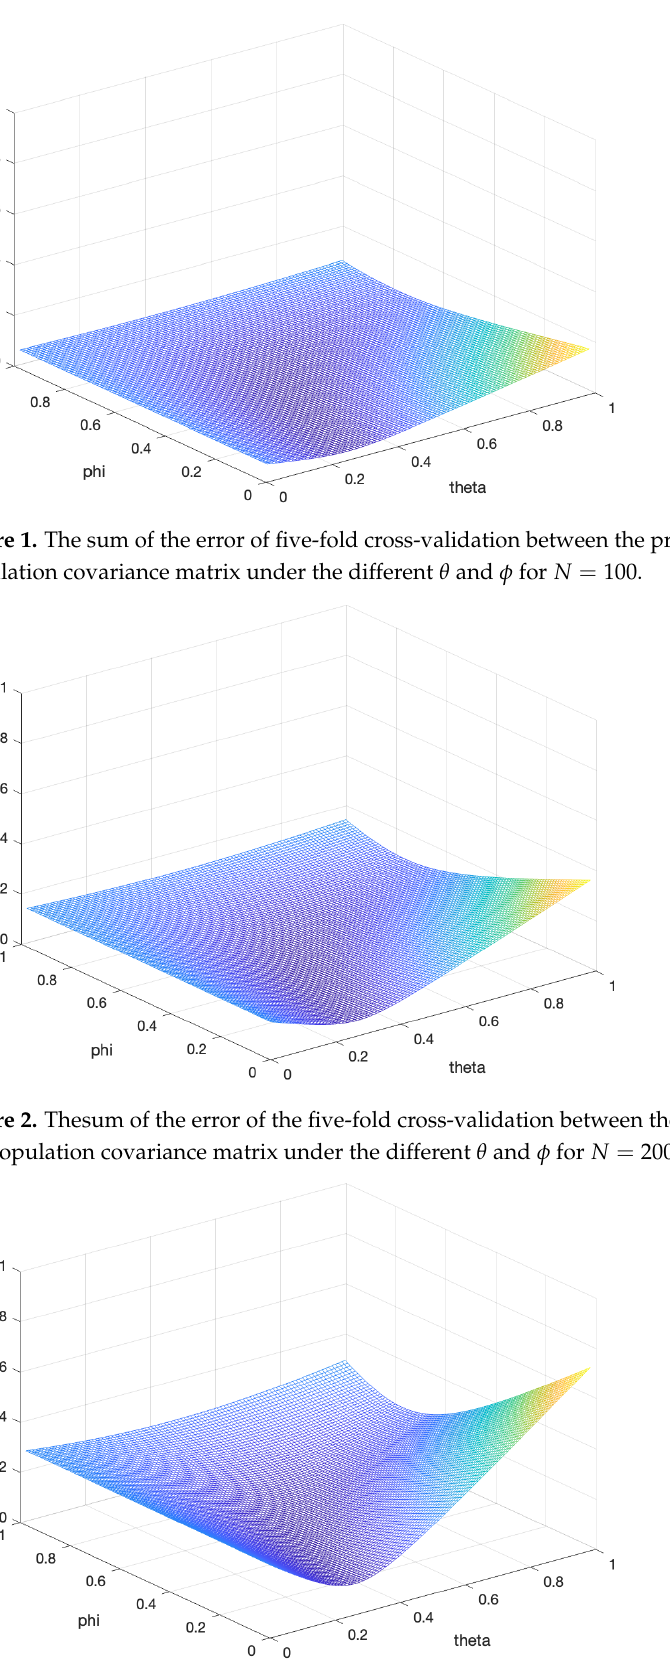
Figure 3. The sum of the error of the five-fold cross-validation between the proposed estimation and the population covariance matrix under the different θ and φ for N =